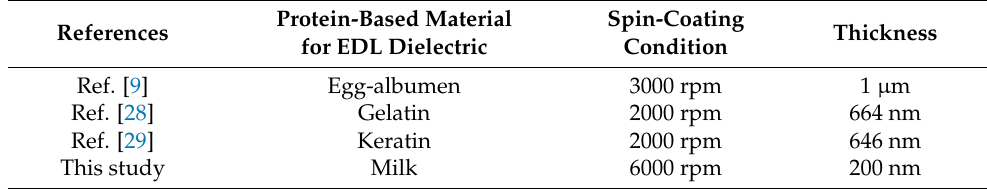
Figure 3. ( a ) Optical transmittance of bovine milk polymer-EDL membrane on a glass substrate. ( b ) Surface roughness properties of bovine milk polymer-EDL membrane.